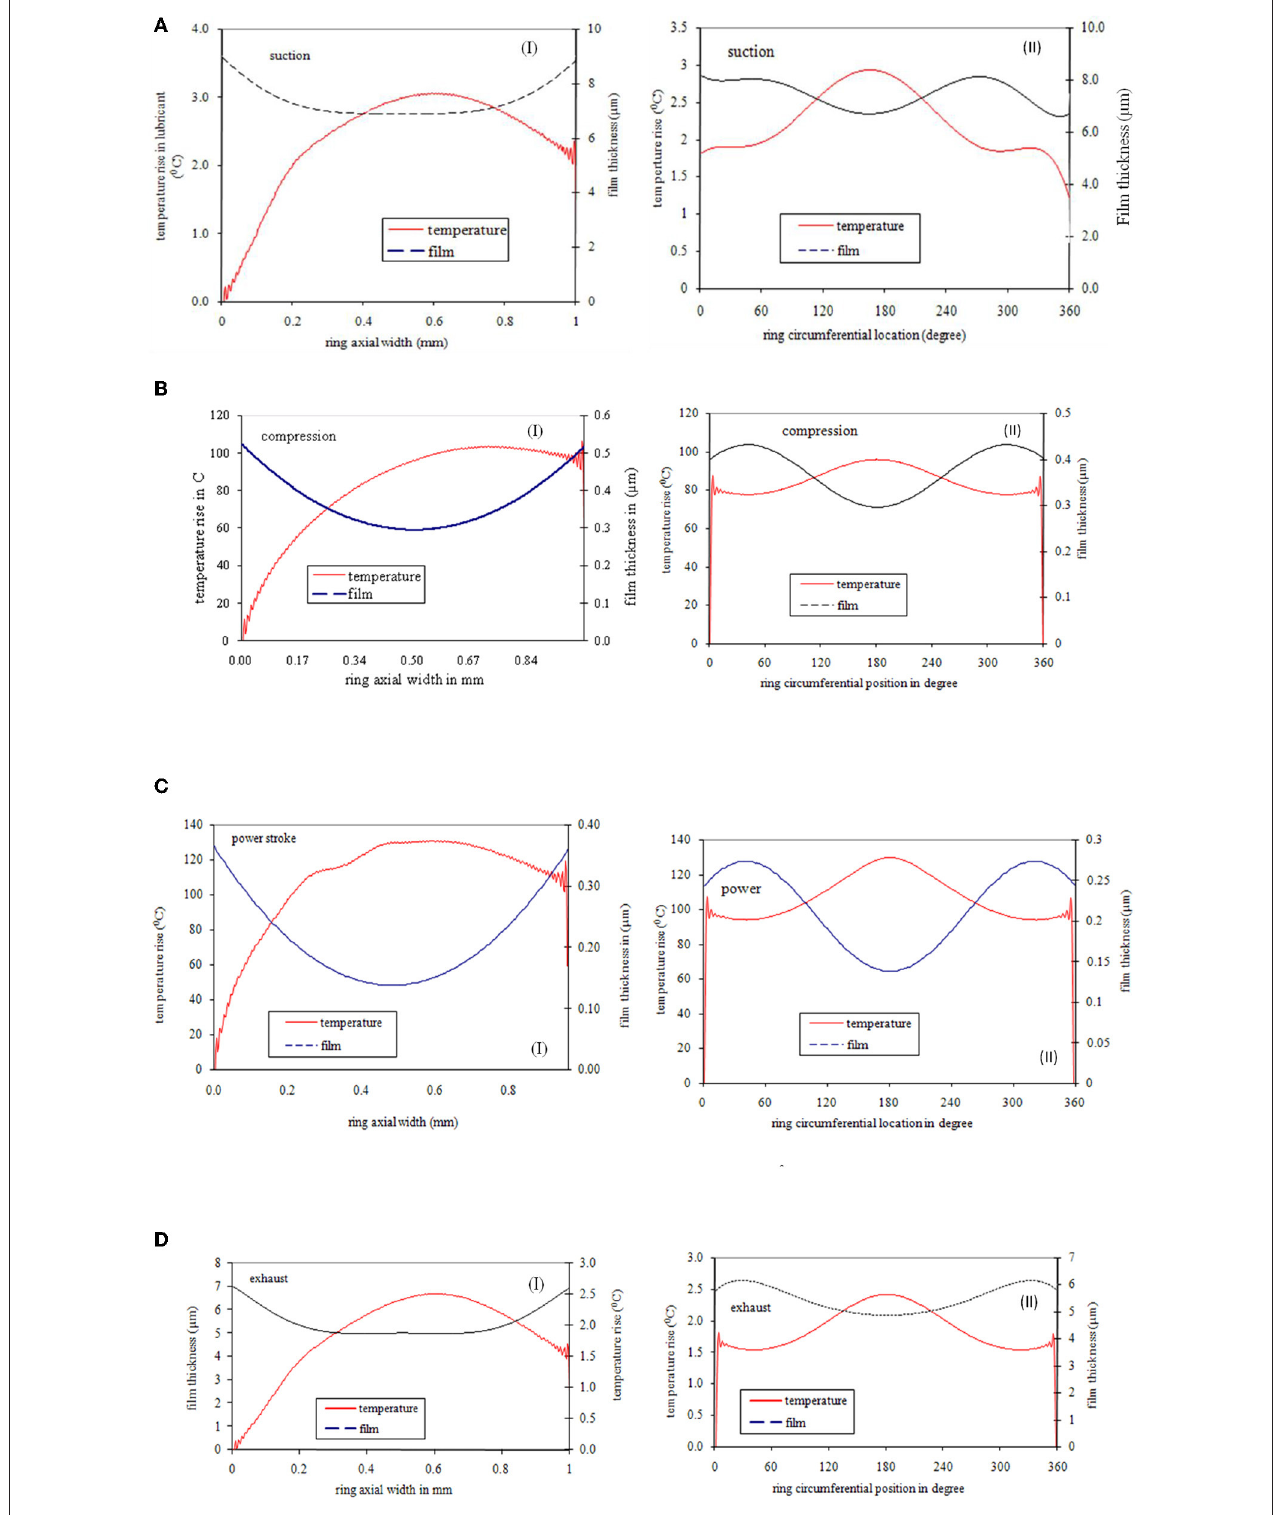
FIGURE 10 | (A) Film and temperature variation in suction stroke ( θ c compression stroke ( θ c η 0 0.004 PaS, U =